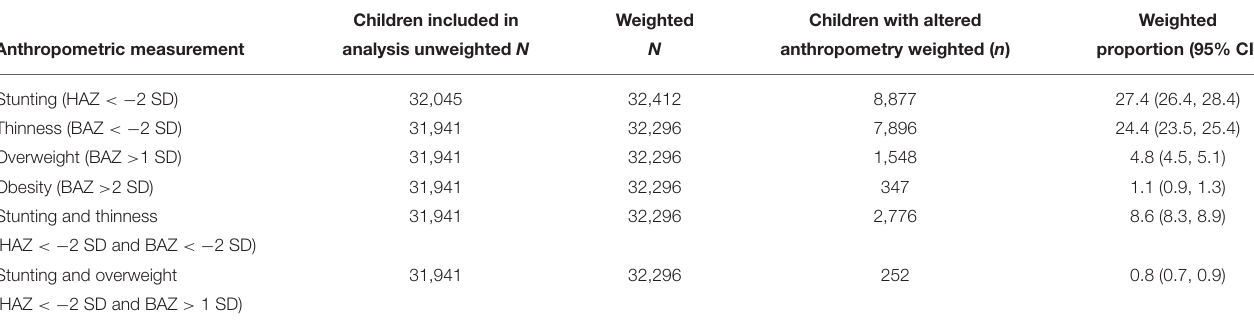
TABLE 1 | Burden of stunting (Height-for-age Z score < − 2 SD), Thinness (BMI-for-age Z Score (BAZ) < − 2 SD), Overweight (BAZ > 1 SD), Obesity (BAZ > 2 SD) among Indian children aged 10–19 years from Comprehensive national nutrition survey data collected during 2016–2018. Children included in Weighted Children with altered